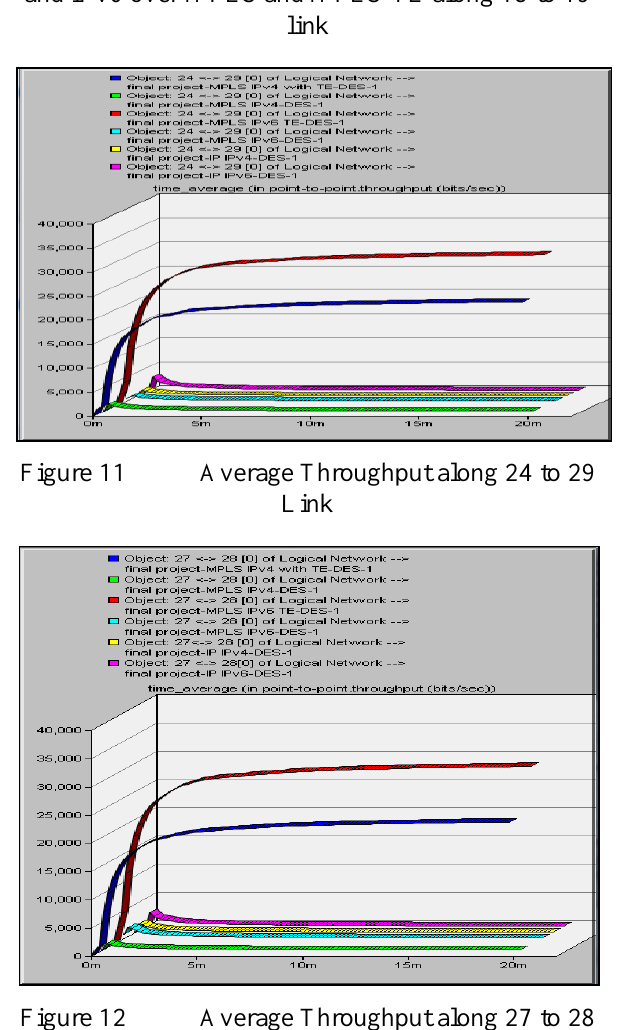
Average Throughput along 27 to